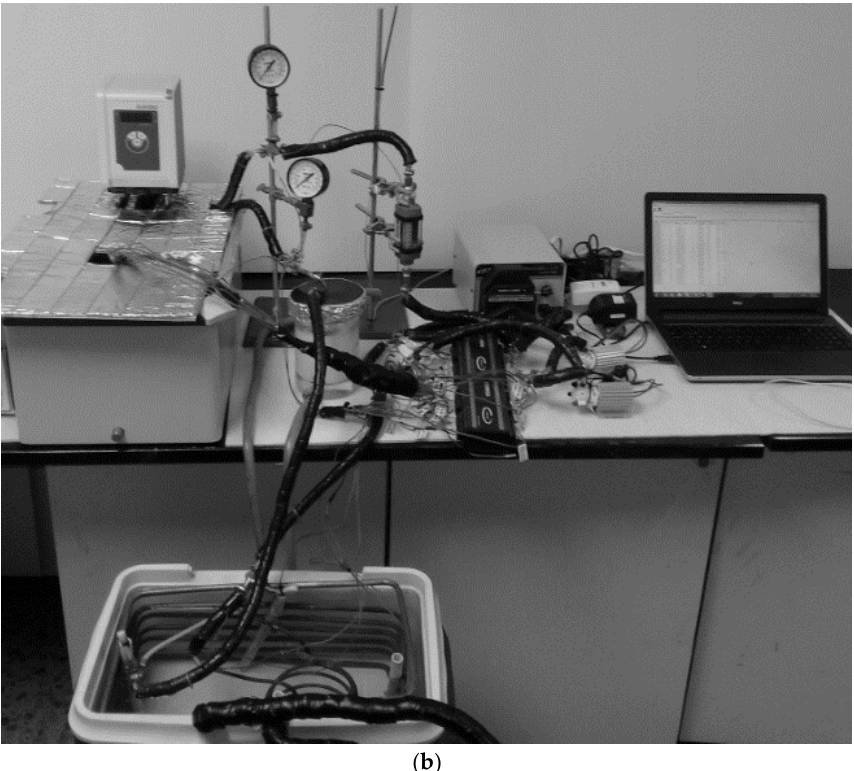
Figure 1. ( a ) Schematic of the experimental test rig. ( b ) Photograph of the experimental setup.